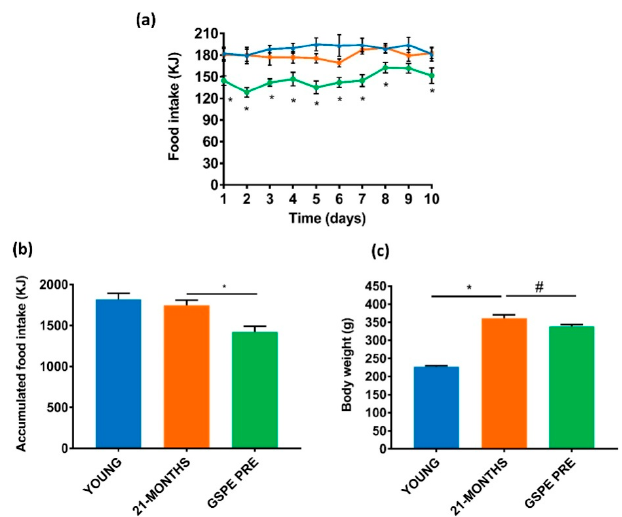
Figure 2. Effect of the 10-day treatment on food intake and body weight. ( a ) Daily food intake, where blue, orange and green represent YOUNG, 21-MONTHS and GSPE PRE groups, respectively. ( b ) Accumulated food intake over the 10 days of treatment. ( c ) Body weight at day 10. Values are means ± SEM. * p -value < 0.05, # p -value < 0.1 compared with 21-MONTHS rats.